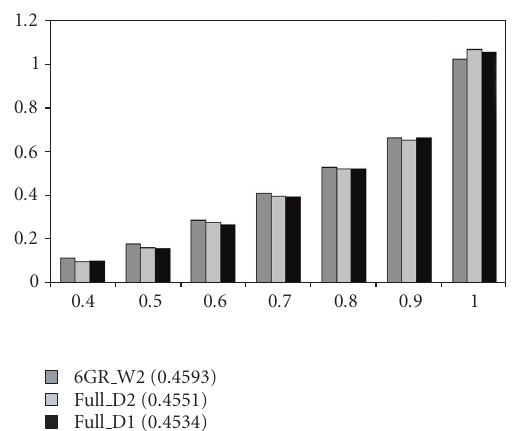
Figure 2. The entropy for substitution tables with a standard context (full D1), a wider but grouped context (6GR W2), and a more distant context (full